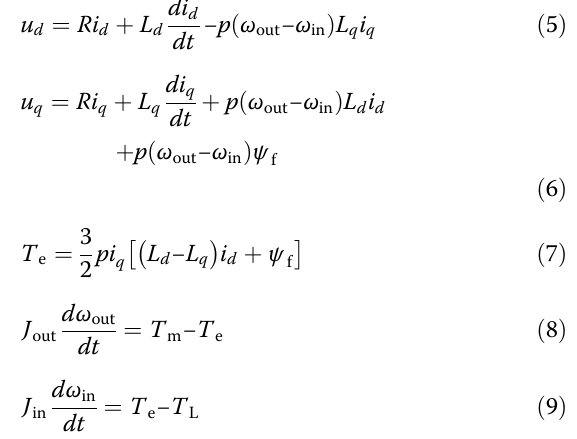
where u d and u q are the dq axis components of the